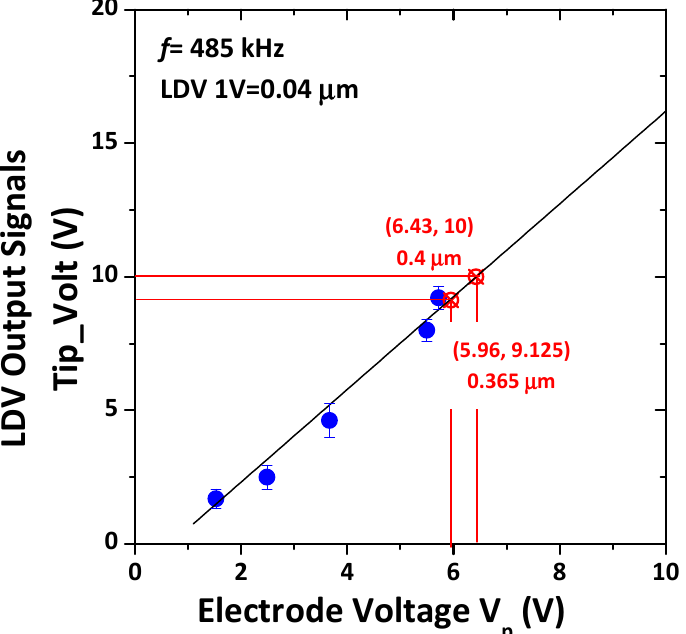
Figure 7. Output signals of longitudinal vibration at the nozzle tip versus applied electrode voltage at the base of the silicon-based three-horn Fourier nozzle.